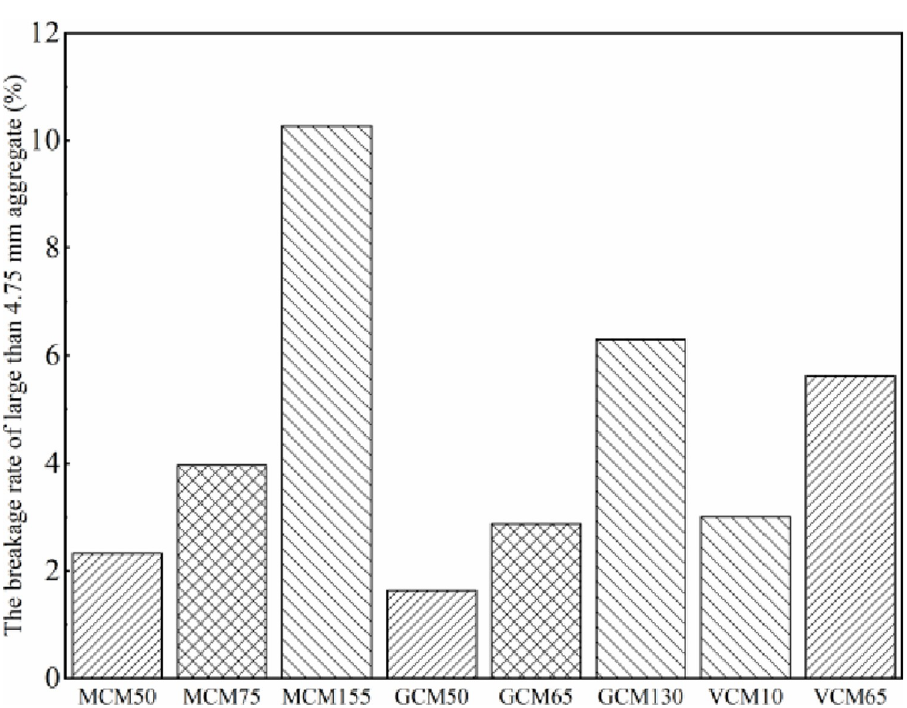
Fig 15. The breakage of large 4.75 mm aggregates of different compaction